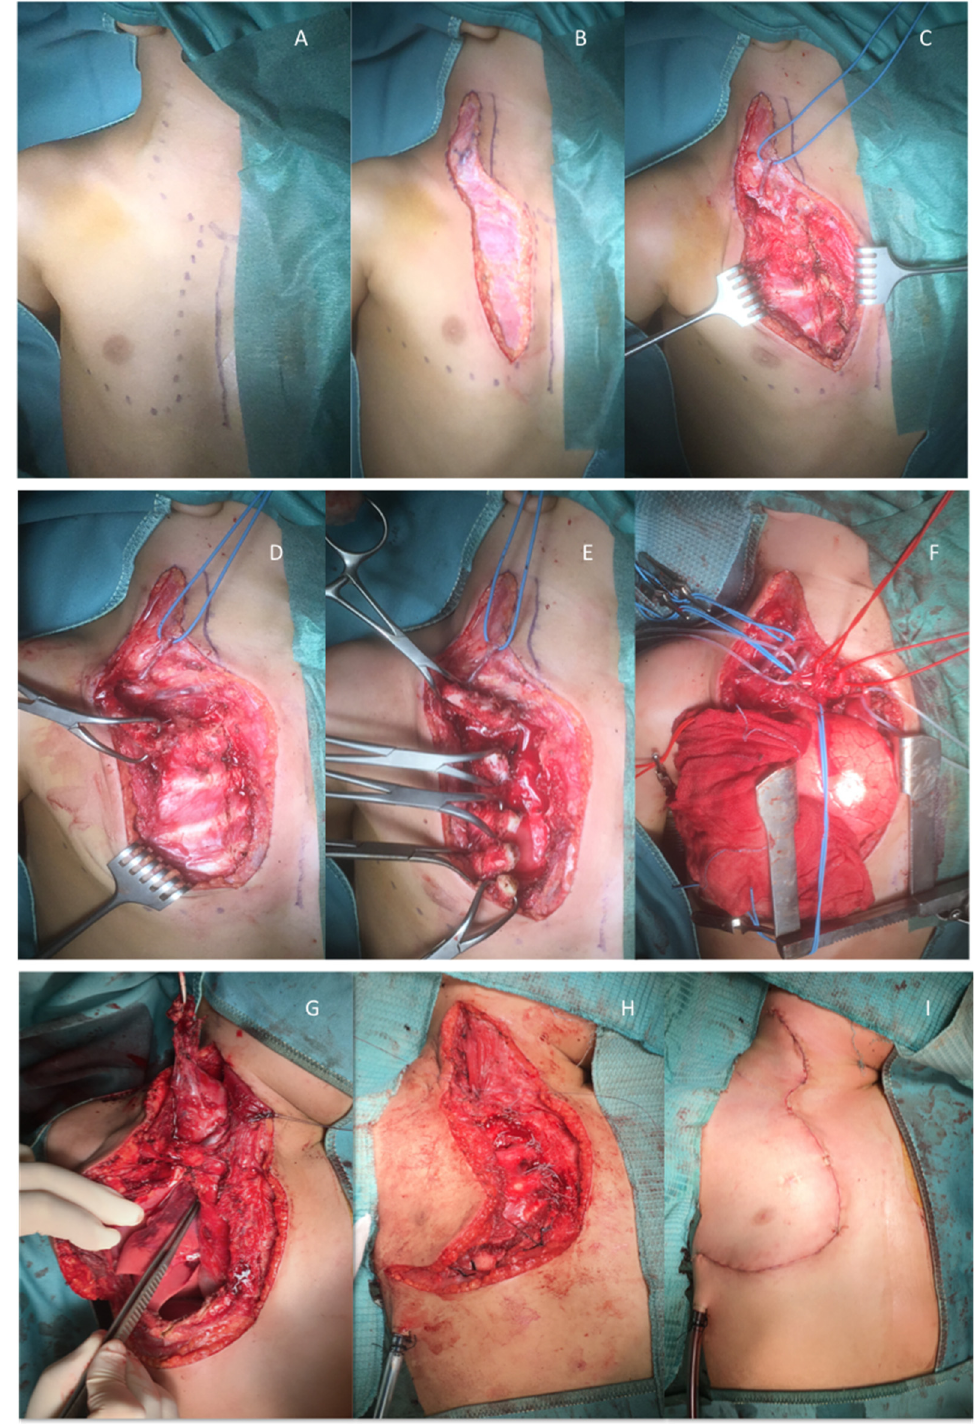
Figure 3. Main steps of the Cervico-Parasternal Thoracotomy (CPT). ( A ). Incision line for CPT type A. ( B , C ). Surgical dissection of the subcutaneous tissue. ( D , E ). Detachment of the major pectoralis muscle and identification and disarticulation of the clavicle and the ribs from their sternal insertion. ( F ). Identification and isolation of vital structures: common carotid artery (red elastic wire), subclavian artery (red elastic wire), internal jugular vein (blue elastic wire), phrenic nerve (white elastic wire). ( G – I ). Main steps and incision line for CPT type B.